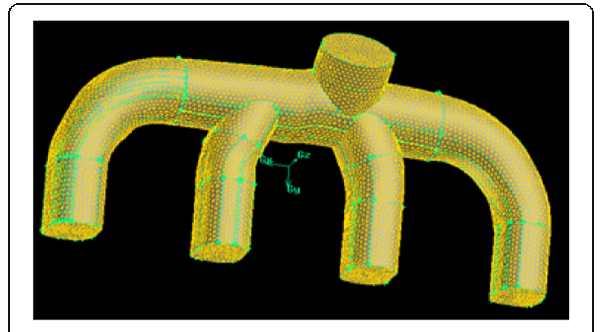
Fig. 7 Improved manifold grid